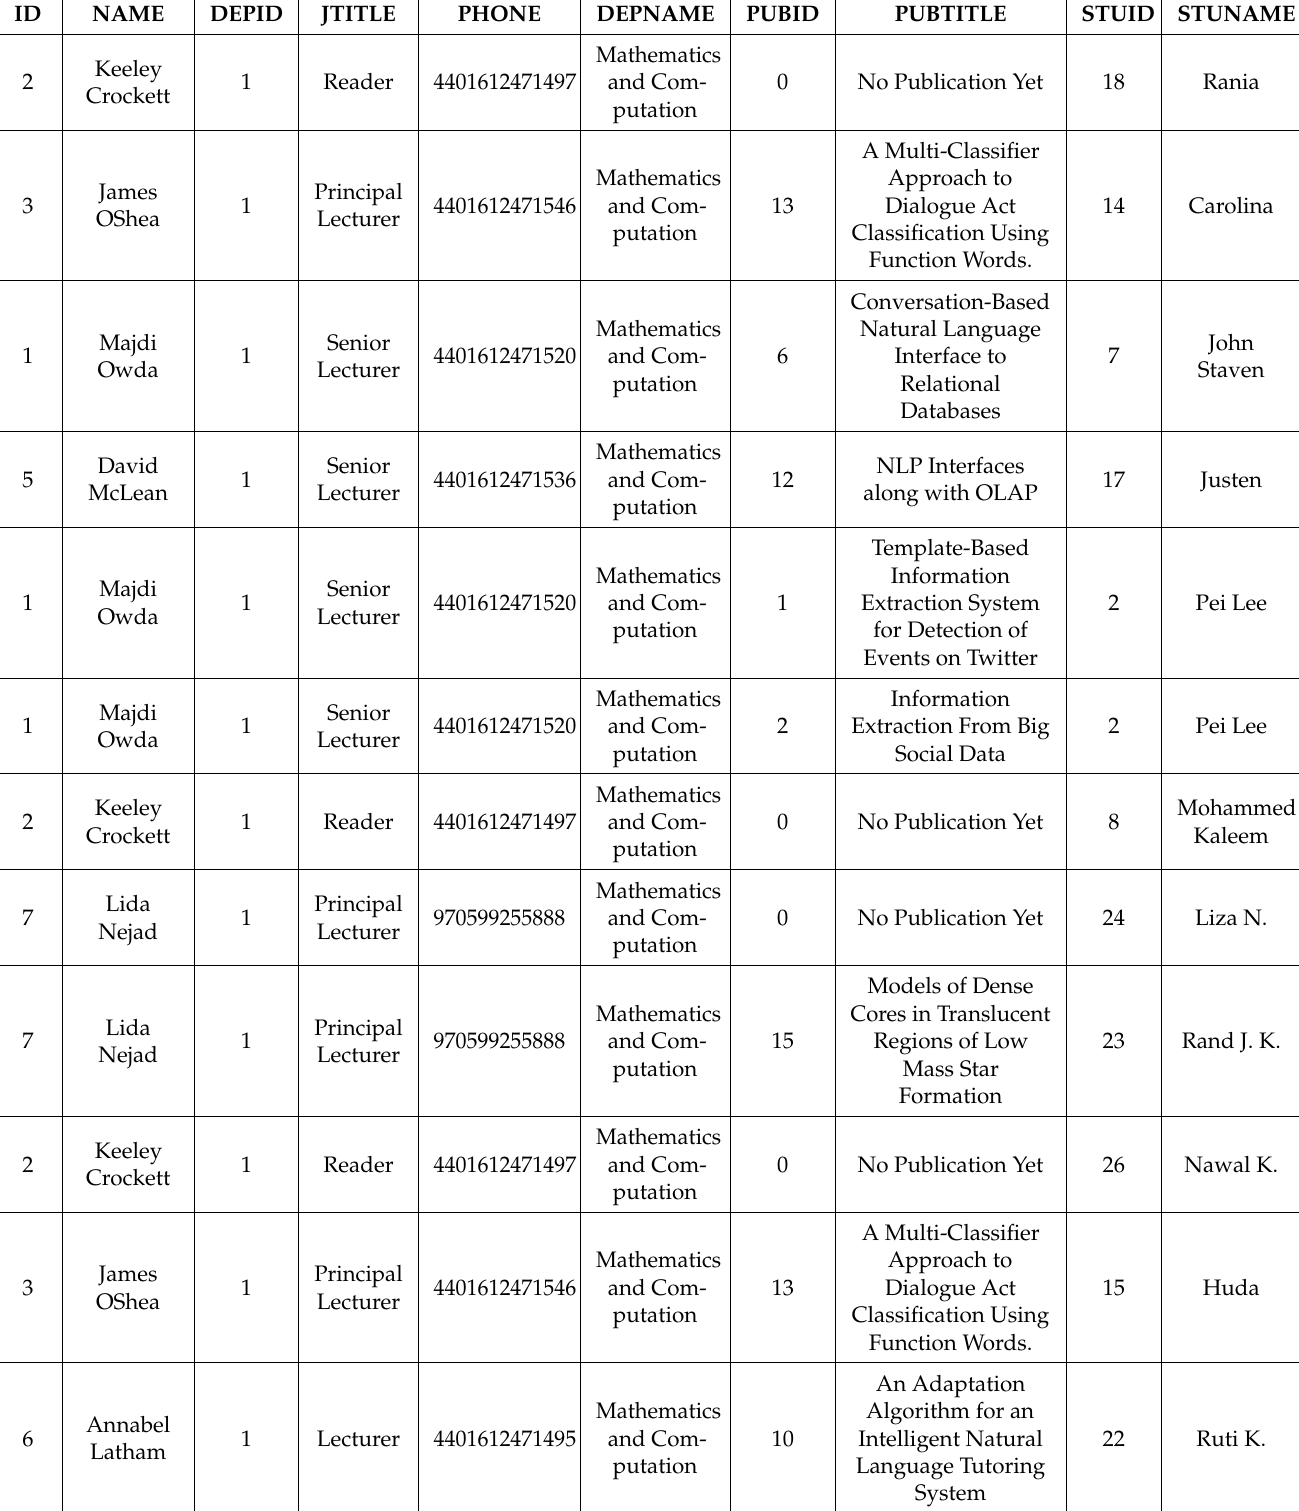
Table 3. Example (2): dynamic screen